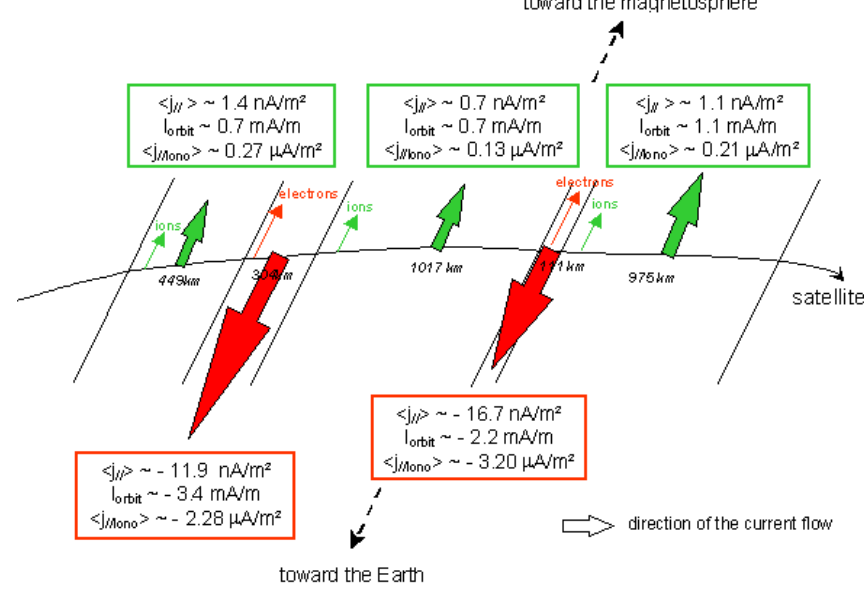
Fig. 13. Summary sketch of the suggested current geometry for a polar cap crossing by northward IMF. The red (green) arrows point toward the Earth (magnetosphere) and represent the downgoing (upgoing) currents mostly carried by the electron beams (ion structures). Encapsulated values correspond to the results obtained on 20 March 2003 between 00:38 and 00:51